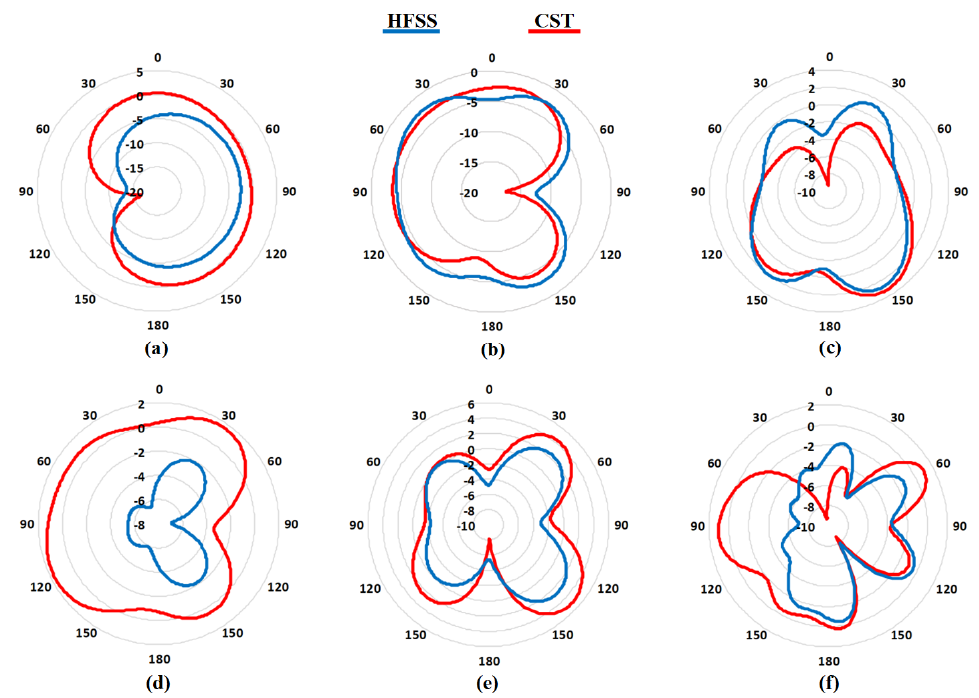
Figure 13. Simulation of antenna’s radiation pattern at frequencies of 2.45 GHz, 5.8 GHz, and 8.0 GHz: ( a – c ) E-Plane and ( d – f ) H-Plane.